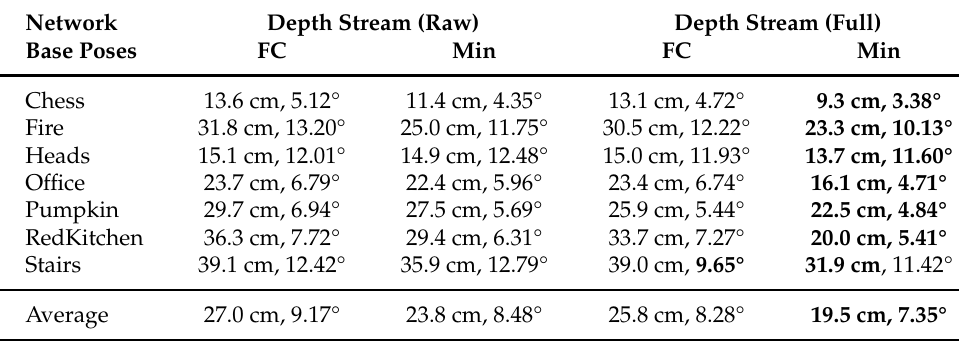
Table 5. Median translation error (cm) and rotation error (°) for four single depth streams with raw/full depth images as input and learning-based/handcrafted base poses on 7 Scenes dataset. Bold numbers indicate the lowest error